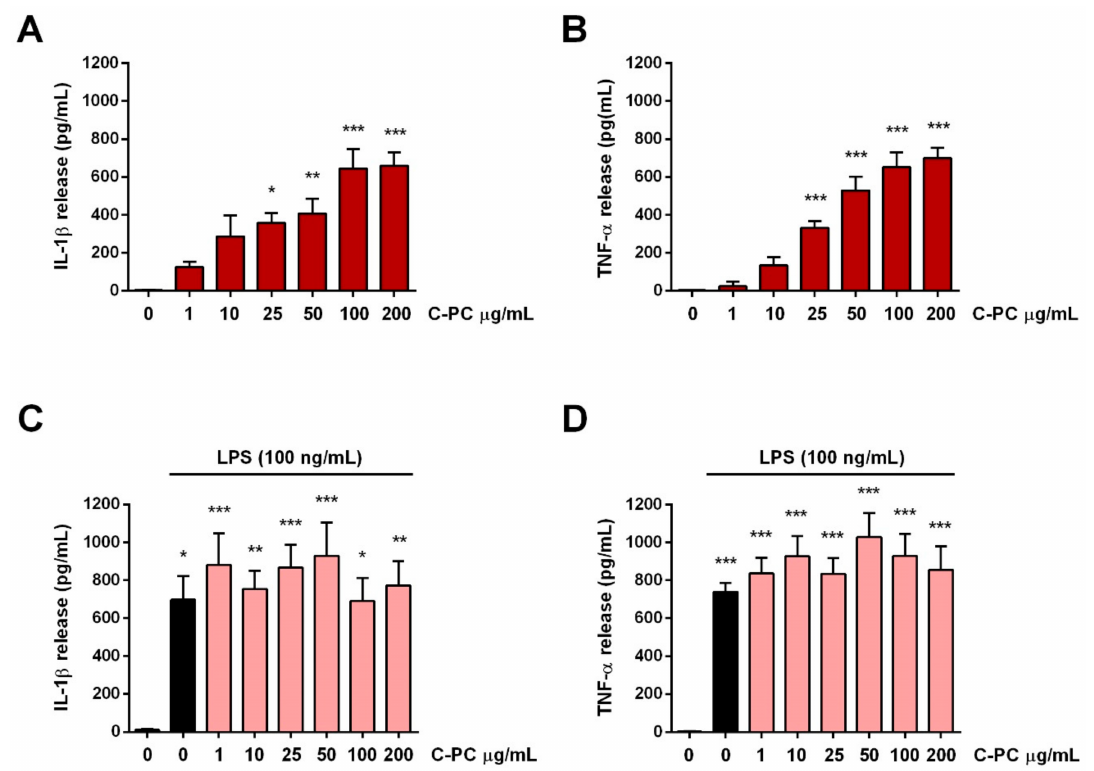
Figure 2. Effect of C-phycocyanin on cytokine release from cortical microglia. Microglia were cultured overnight medium containing 10% of serum, which was replaced with serum-free medium before treatment with C-PC ( A , B ) or C-PC + LPS (100 ng/mL) ( C , D ). After the exposure to C-PC or LPS for 16 h, supernatants were collected and analyzed for IL-1 β ( A , C ) and TNF- α ( B , D ) content. Data are means ± SEM ( n = 3 in triplicate). * p < 0.05, ** p < 0.01, and *** p < 0.001 versus control cells. One-way ANOVA followed by Holm–Sidak’s test.